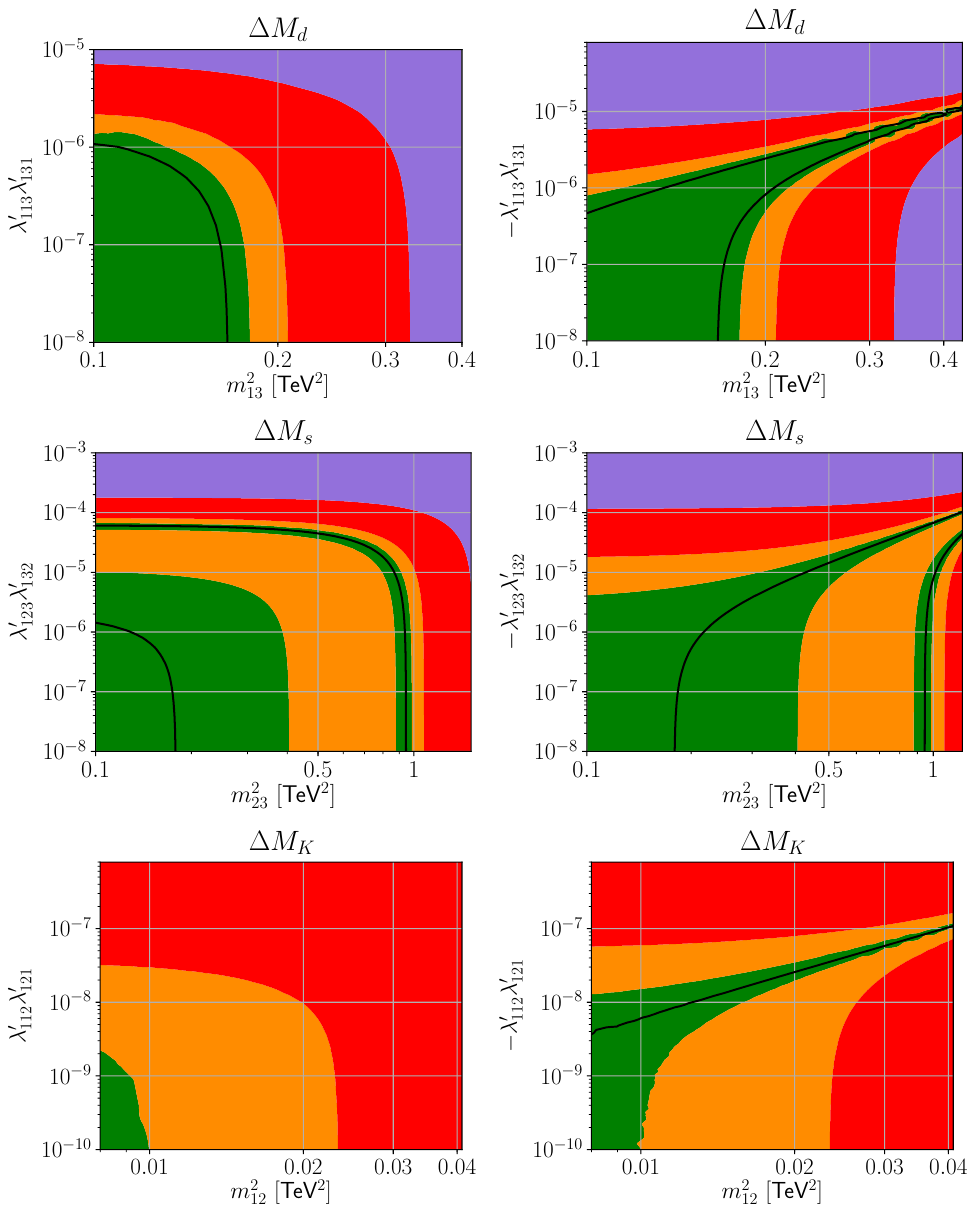
Figure 9. Constraints from the meson-oscillation parameters in the presence of both (cid:13)avor- violating LQ (cid:22) D -couplings and ( R p -conserving) (cid:13)avor-violating mixing in the squark sector. The spectrum is set to the scenario SUSY-RpV(a) of table 1, with the slepton/sneutrino mass at 1 : 5 TeV. The (cid:13)avor-violating quadratic soft mass parameters in the squark sector, m 2 degenerate for left-handed and right-handed squarks. The color code follows the same conventions as before.